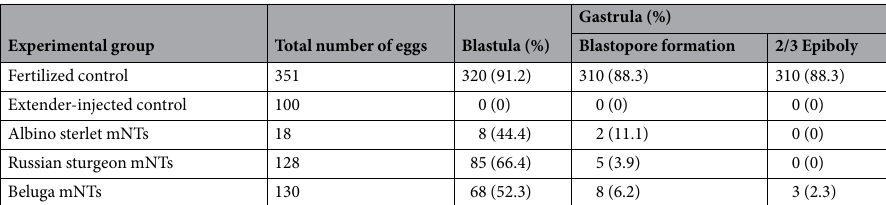
Table 2. Developmental rates of the reconstructed embryos (albino sterlet mNTs or Russian sturgeon mNTs or beluga mNTs) after transplantation of fin-cells originated from albino sterlet or Russian sturgeon or beluga, respectively, into sterlet eggs (~329 ± 2 or ~330 ± 12 or ~240 ± 18 fin-cells/egg, respectively). Sterlet control groups are presented at each developmental stage respectively to